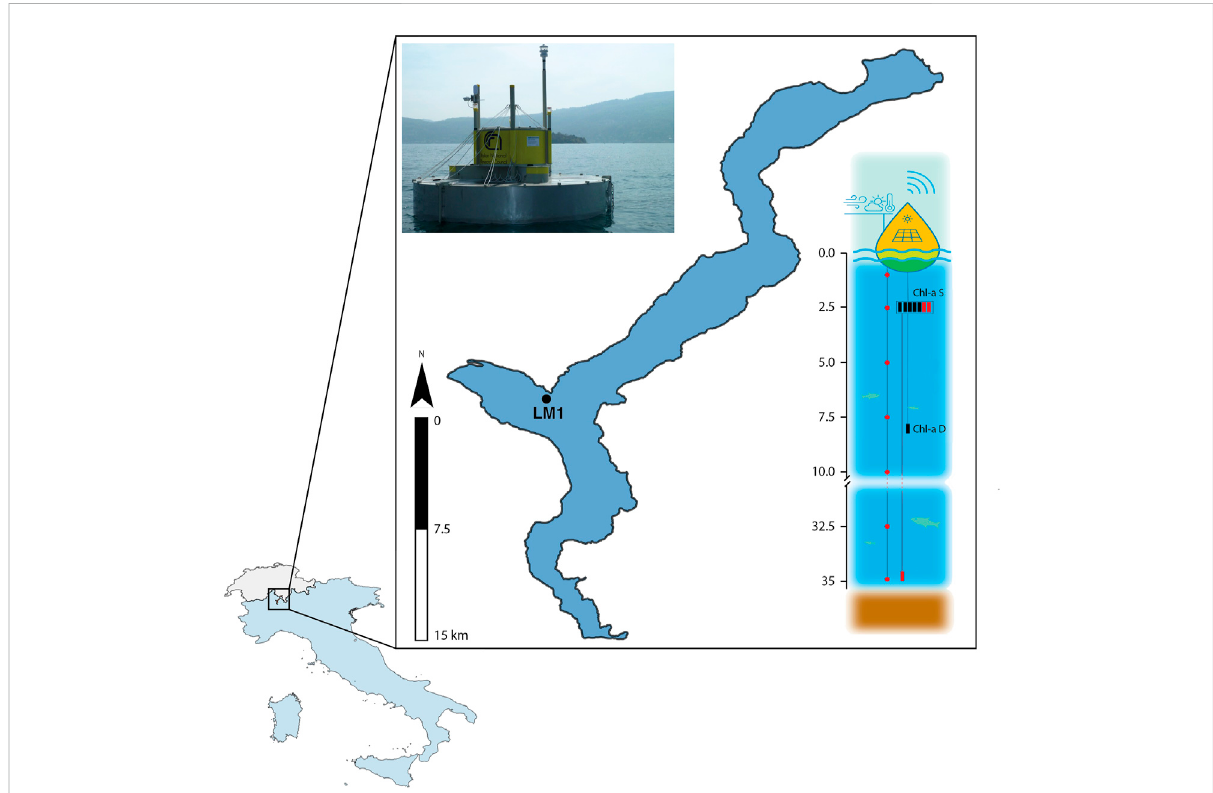
FIGURE 1 Locationandmaincharacteristicsofthemonitoring buoyLM1inLakeMaggiore(seeTiberti etal.,2021forthedetails).Onthebottom-leftmap, Italy is coloured blue while Switzerland is